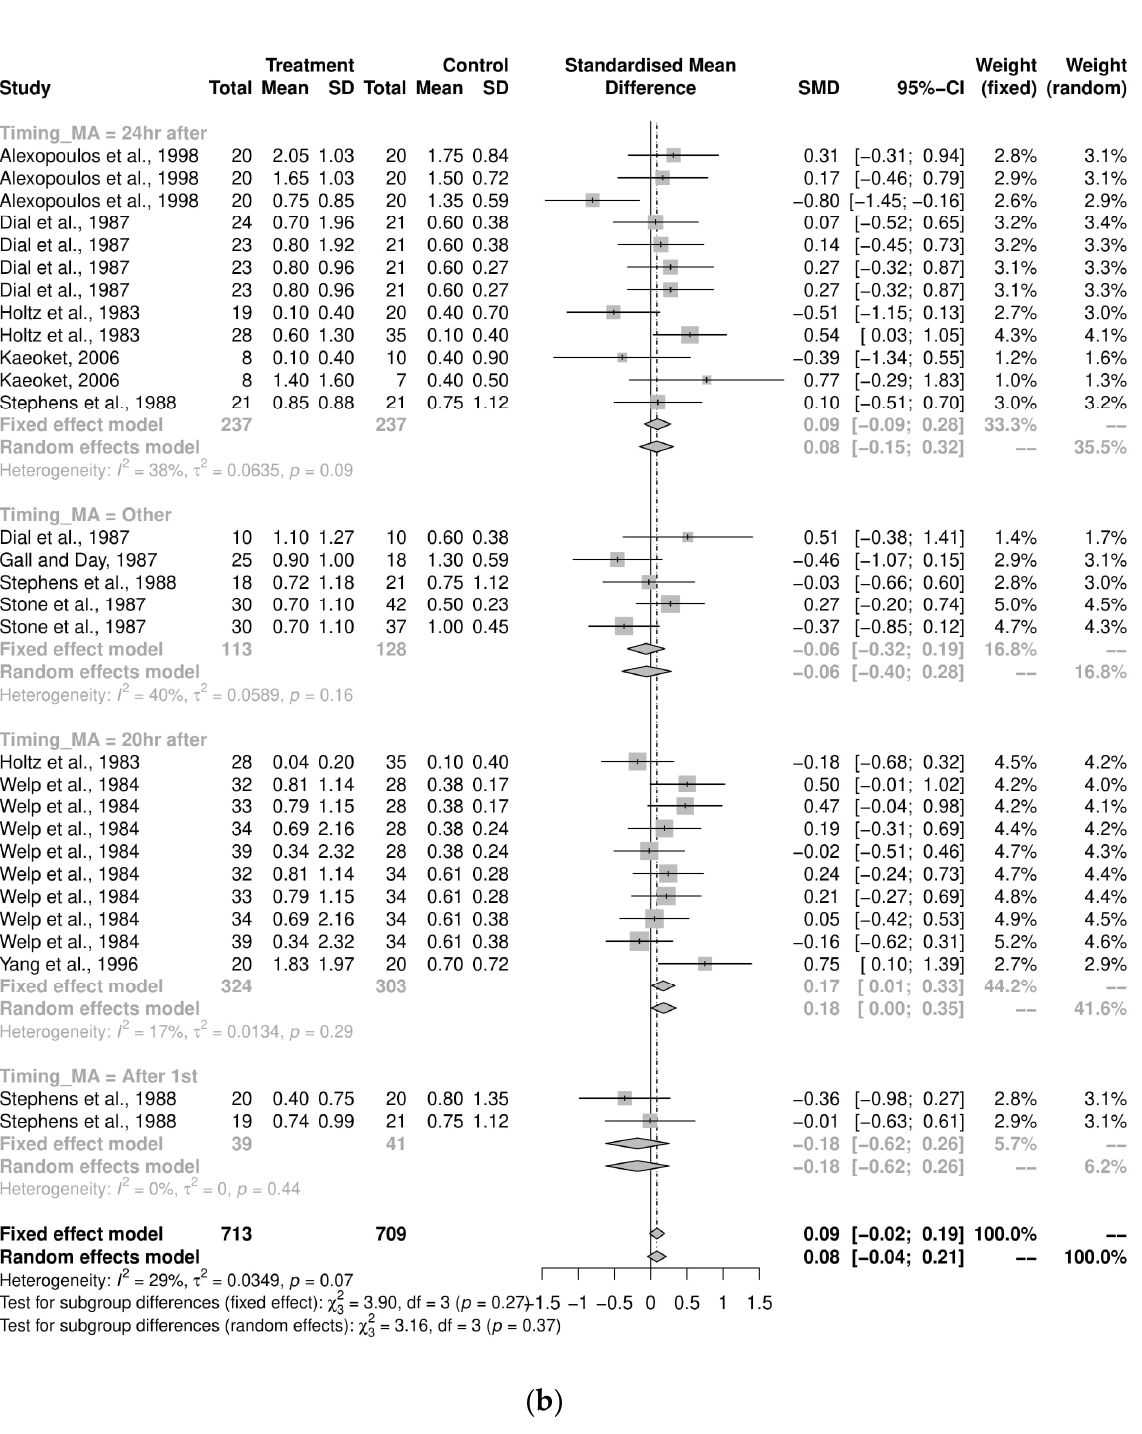
Figure 3. ( a ) Meta-analysis examining mean stillbirths in induction-program studies: Sub-group analyses by dosage [29,33,35,36,38,48,49,52,53]. ( b ) Meta-analysis examining mean stillbirths in induction-program studies: Sub-group analysis by timing of administration [29,33,35,36,38,48,49,52,53].